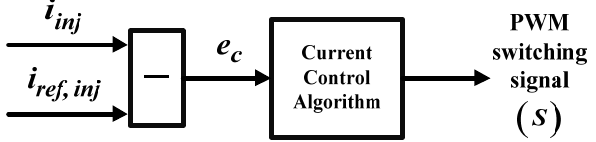
Figure 8. Conceptual model of direct current control (DCC) scheme.